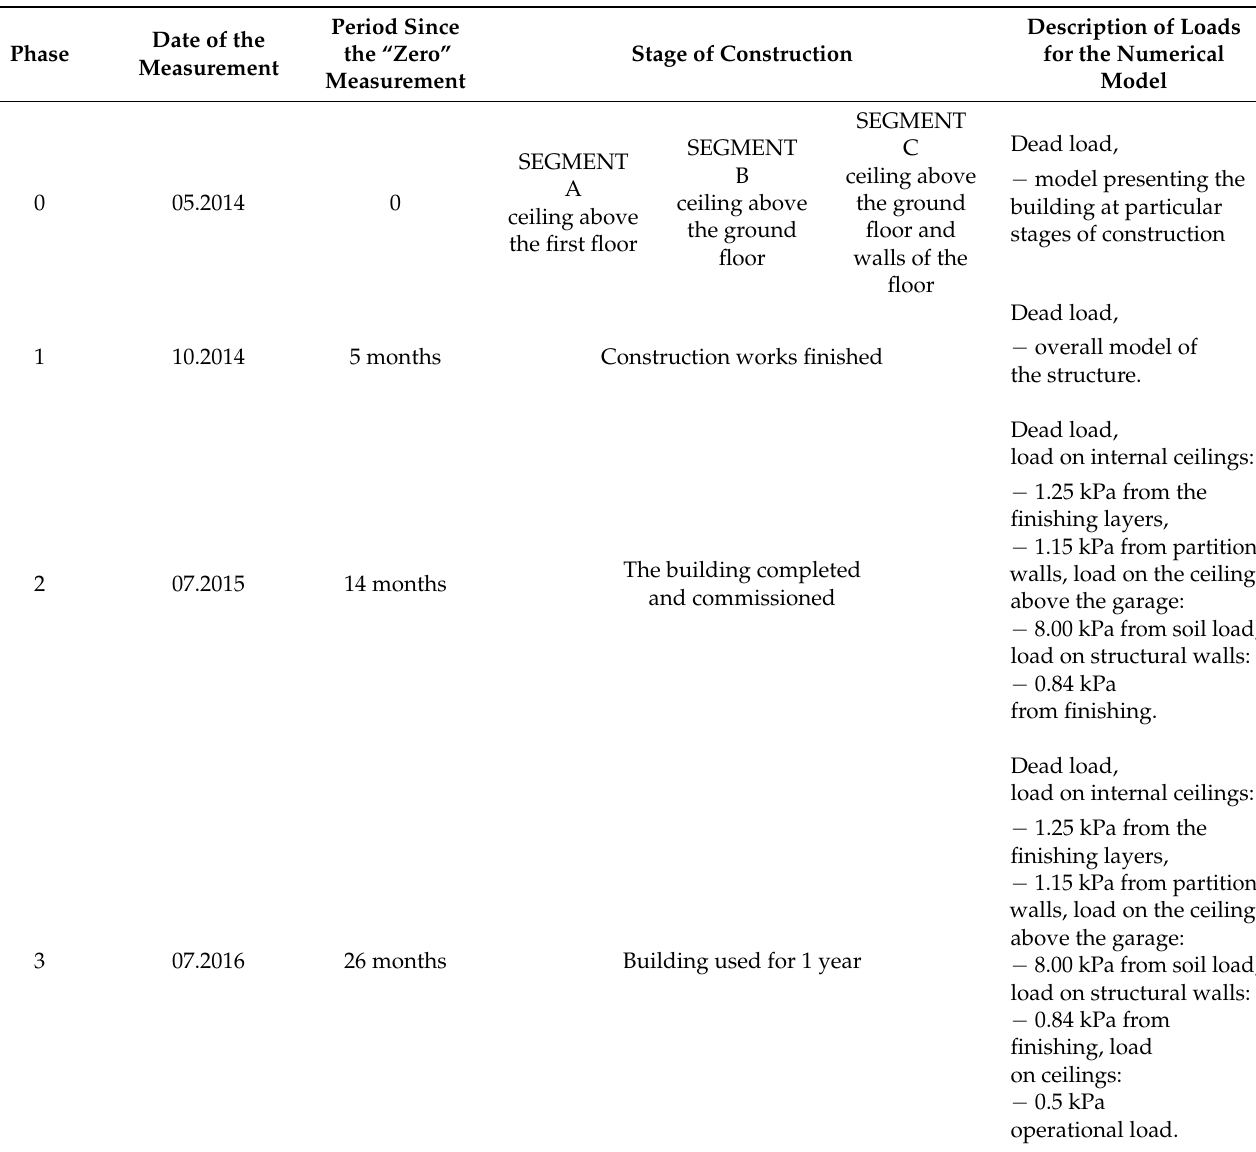
Table 1. Stages of geodetic measurements and loads for the numerical